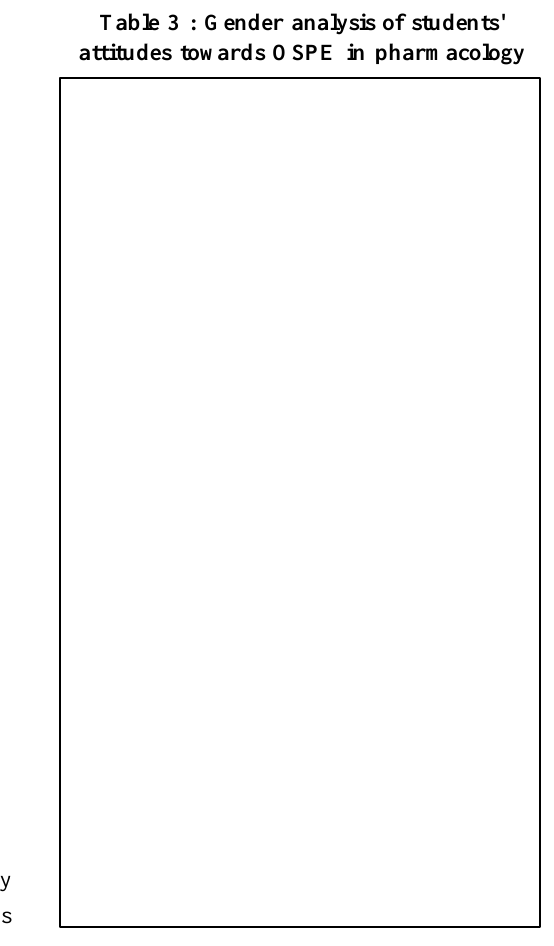
Table 2 : Mean of the attitudes of medical students towards OSPE in pharmacology